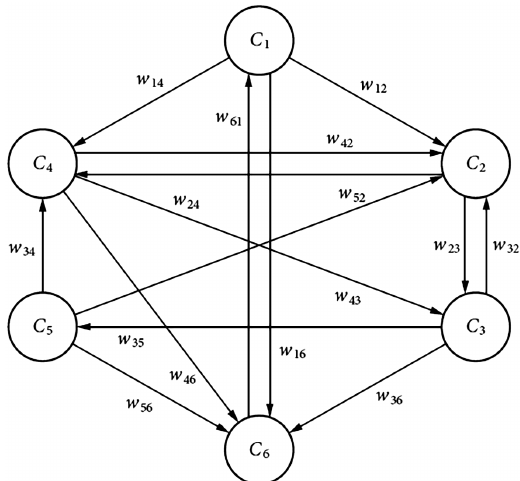
Figure 1. Example of an FCM (source: Kang, Deng, Sadiq, and Mahadevan, 2012, p.